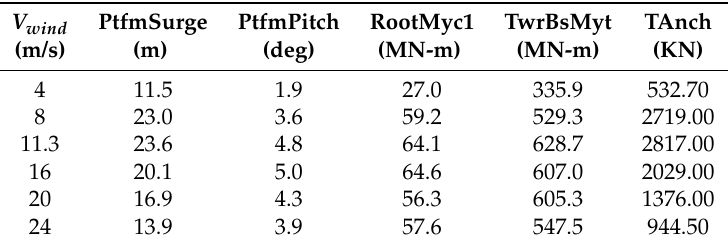
Table 14. Statistics (Maxima) of the integrated SNL 13.2-MW semi-submersible floating offshore wind turbine